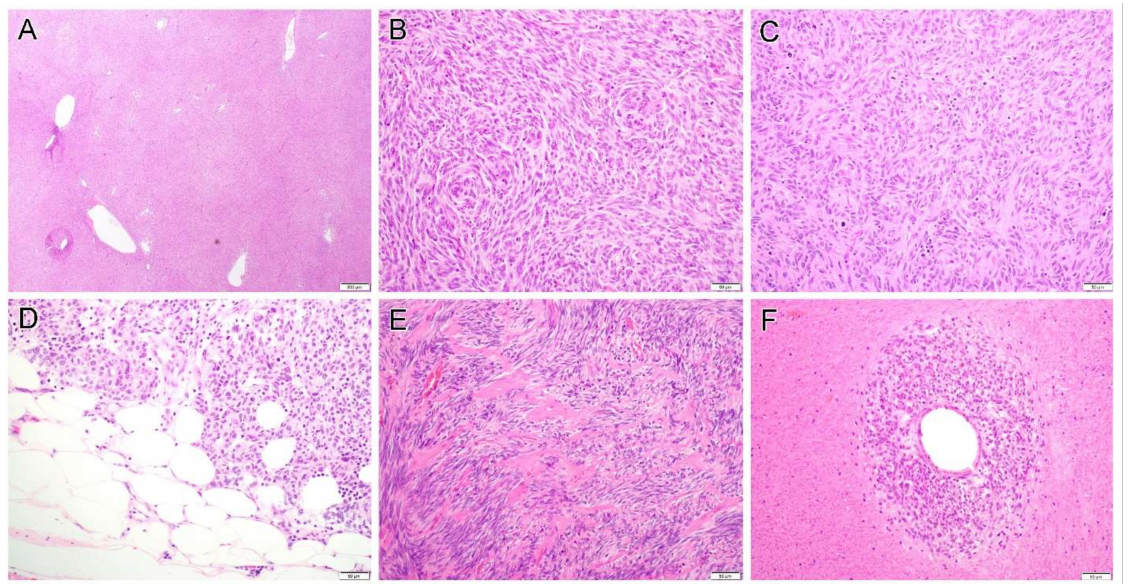
Figure 3. Gastrointestinal stromal tumor displays a variety of growth pattern including heman giopericytoma-like pattern ( A , case 9), storiform ( B , case 9) and haphazard ( C , case 10) tumor growth, and fat involvement ( D , case 13) can be seen in some areas. Some tumors contained hyalinized collagens ( E , case 11). In some cases, viable cells are present only around the blood vessel and ghost-like outlines of necrotic atypical tumor cells can still be discerned in the surrounding tissue ( F , case 16). Original magnification: ( A ), × 20; ( B – F ), × 200. All tumors (20/20, 100%) were diffusely immunoreactive for c-KIT (Figure 4F). The tumor cells were also diffusely positive for DOG-1 (10/10, 100%, Figure 5E) and displayed focal to diffuse positivity for CD34 (11/12, 92%). Desmin was focally and weakly expressed in one of fourteen tested tumors (1/14, 7%), whereas two of eight tumors (2/8, 25%) showed focal SMA positivity. All tumors were negative for AE1/AE3, Inhibin, SF-1 and S100, if these markers were tested.